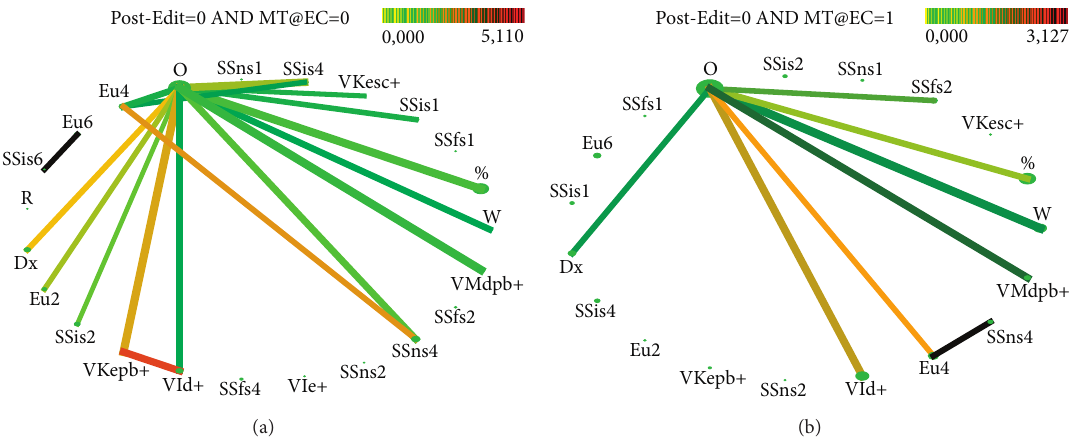
Figure 2: Visualization of tags identified in MT output translated by GT (a) and MT@EC (b).